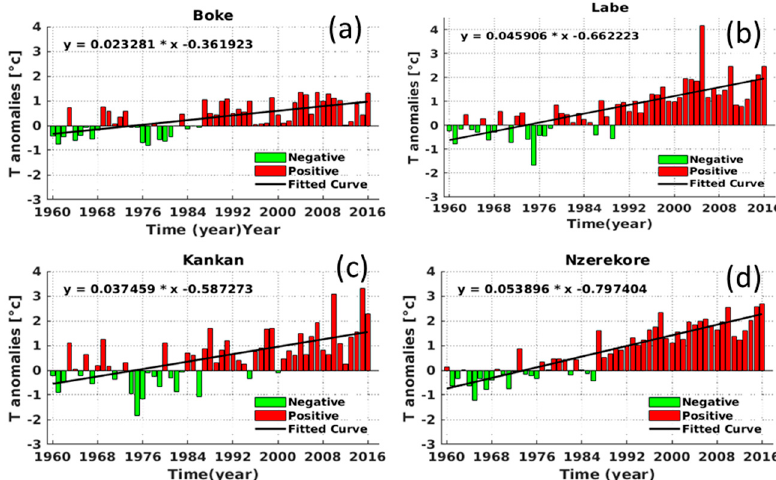
Figure 7. Inter-annual evolution of the surface temperature anomalies (°C) calculated for the station of ( a ) Boke in Lower-Guinea, ( b ) Labe in Middle-Guinea, ( c ) Kankan in Upper-Guinea and ( d ) N’zerekore in Forest Guinea from 1960 to 2016 (relative to the average temperature between 1961 and 1990). The superimposed curves (black line) denote the linear trend.